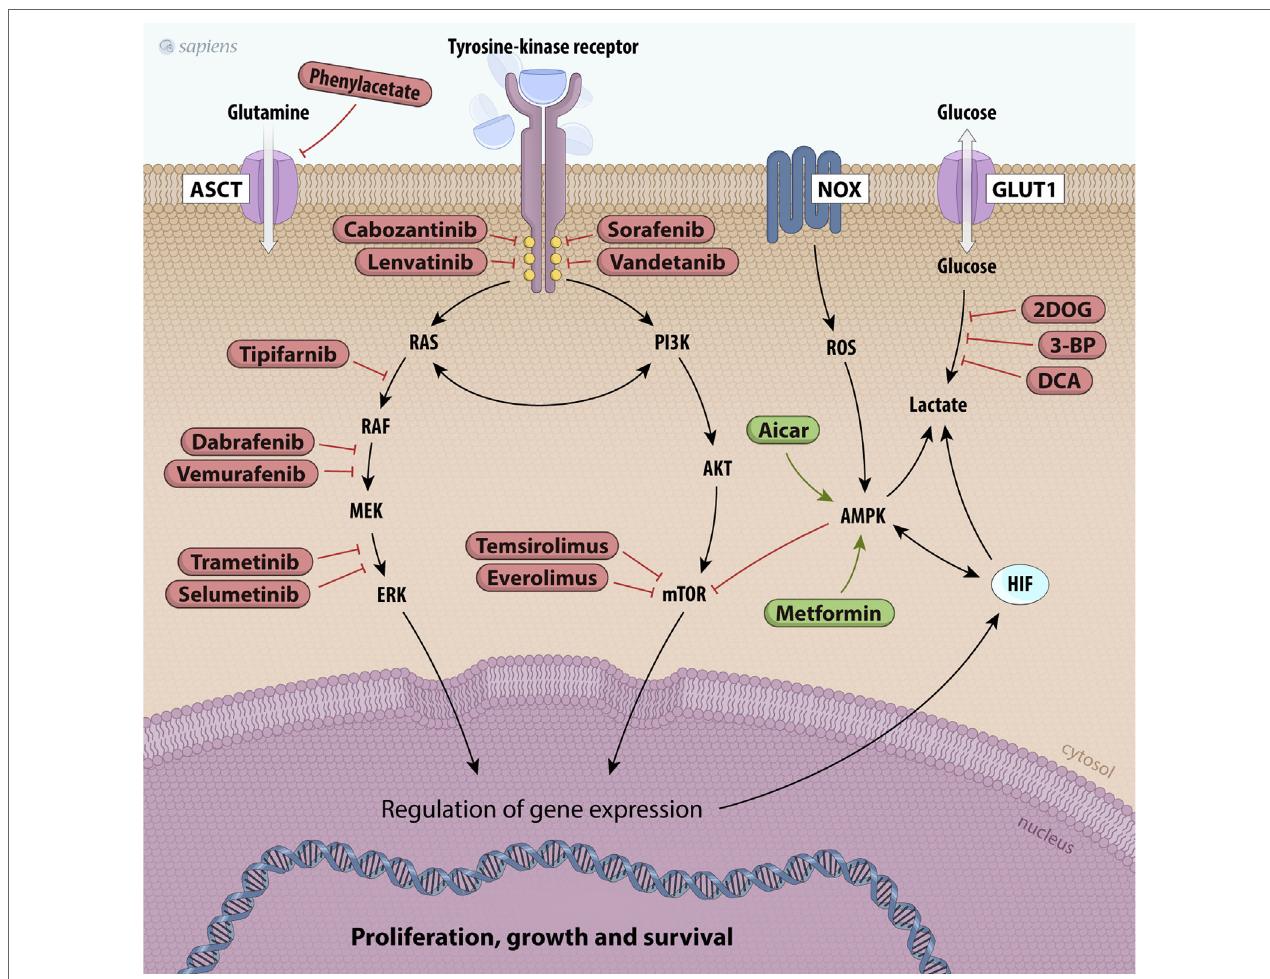
FiGURe 4 | Scheme of principal potential therapeutic targets. The products of mutated genes activated in cancer cells are targets for anticancer drug therapy [Valerio et al. (144), Bible and Ryder (147), and De Falco et al. (148)]. Several kinase inhibitors along the RET/papillary thyroid carcinoma, RAS, PI3K/AKT/mTOR, and MAPK signaling pathways are shown in red. Metabolic alterations in thyroid cancer cells can also be inhibited, such as glutamine uptake (phenylacetate) and glucose metabolism (2DOG, 3-BP, DCA). Finally, other drugs can activate molecules like AMPK, such as metformin and AICAR, which are shown in green. Abbreviations: 2DOG, 2-deoxyglucose; 3-BP, 3-bromopyruvate; DCA, dichloroacetate, AICAR, 5-aminoimidazole-4-carboxamide-ribonucleoside, NOX, NADPH oxidade; MAPK, mitogen-activated protein kinase; AMPK, AMP